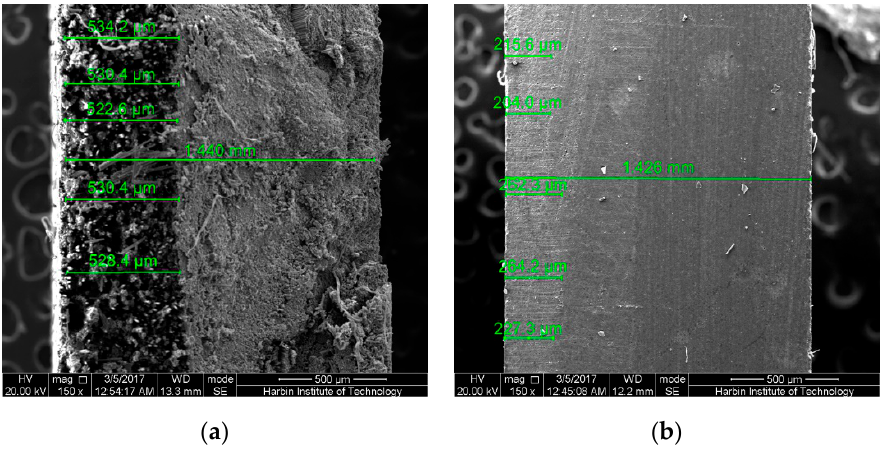
Figure 18. The cross-section in the mid-span region of the PU-based CFRP samples under 58% strain level for 6 months: ( a ) broken samples in seawater at 60 °C, ( b ) unbroken samples in seawater at 60 °C.